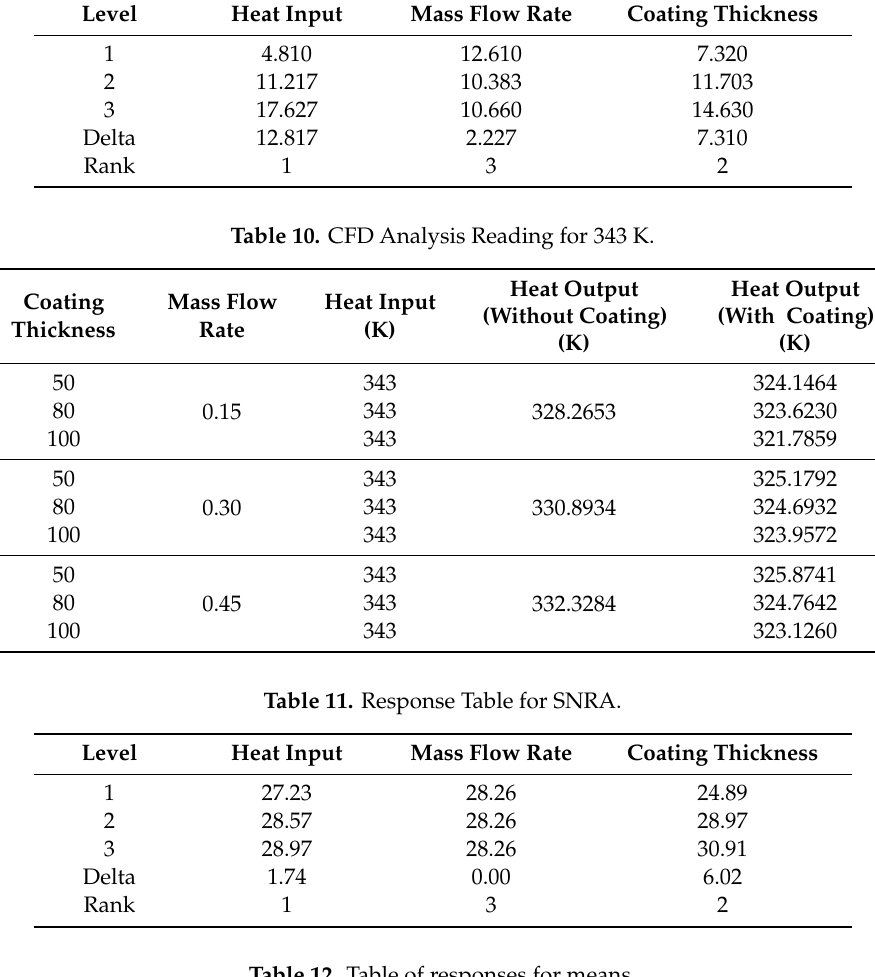
Table 12. Table of responses for